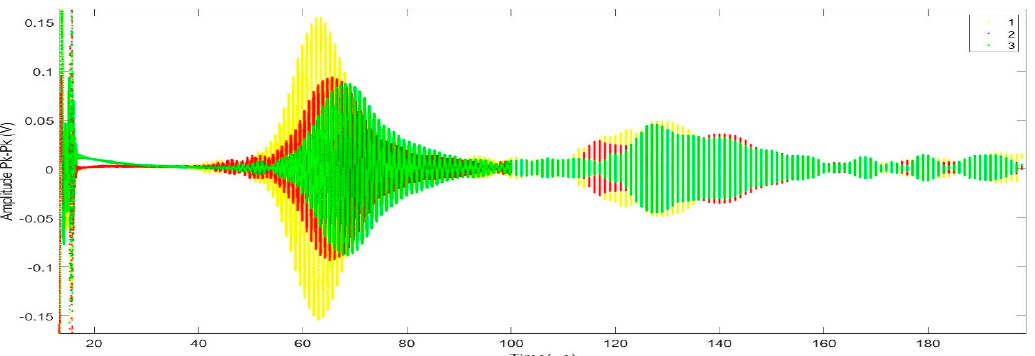
Figure 18. A-scan for one of the tested plates showing the superimposed guided-wave modes from three different elements.[7]